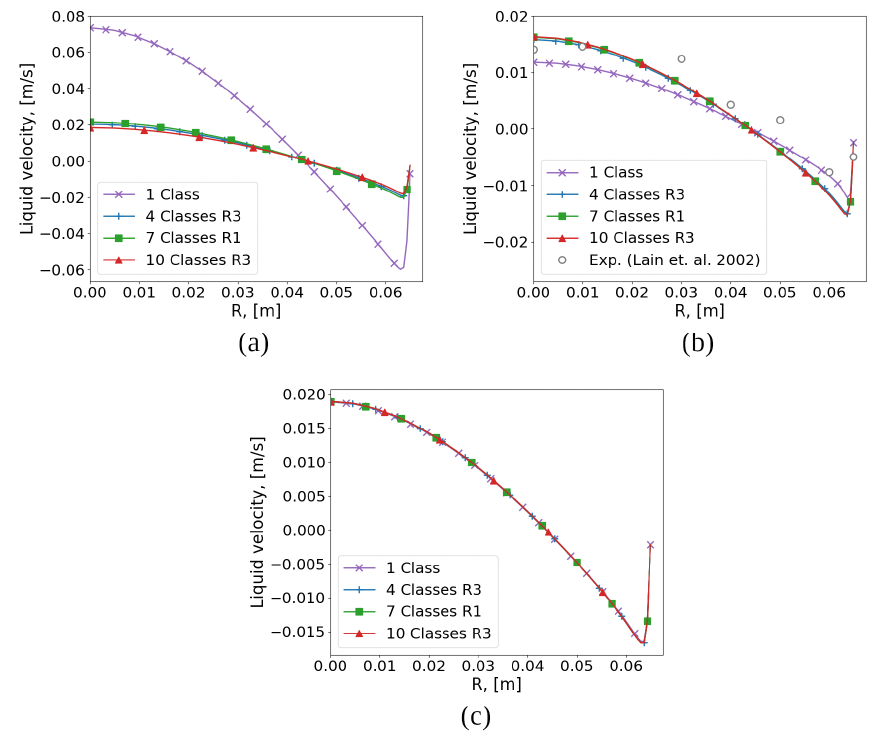
Figure 7. Radial profiles of liquid velocity in the reference cross-section (see Figure 1) for different characteristic bubble sizes: ( a ) M = 0.25 mm; ( b ) M = 0.5 mm; ( c ) M = 1.0